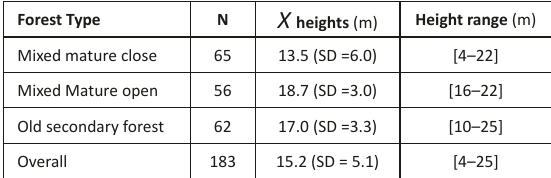
Table 3. Bonobo nest heights in the LTSF Forest